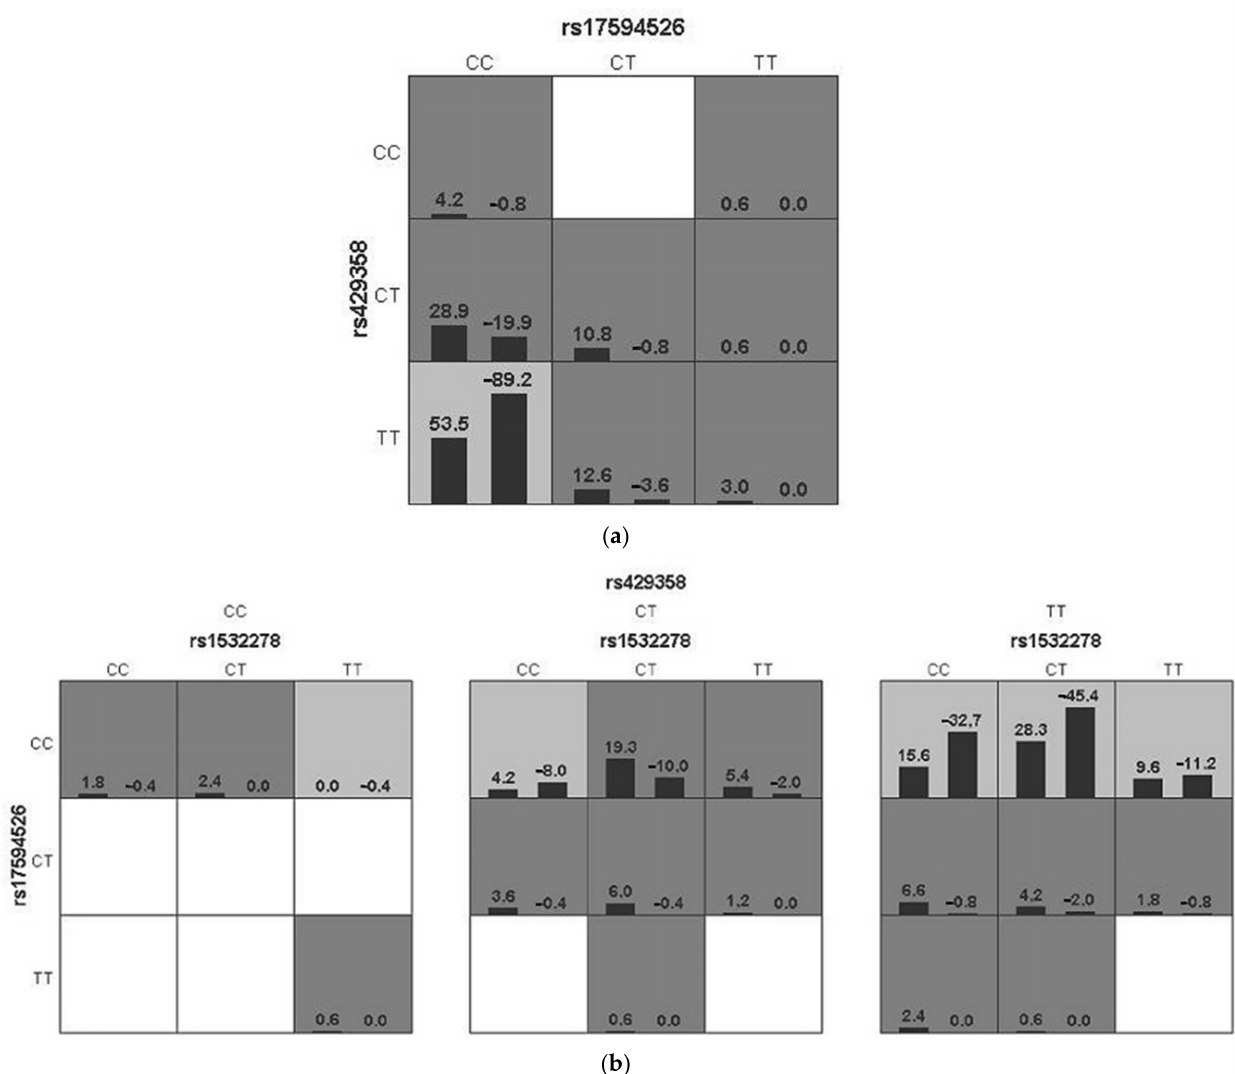
Figure 3. Gene–gene interactions among TCF4 (rs17594526), APOE (rs429358) and CLU (rs1532278) loci in AD and healthy subjects: ( a ) two-factor model; ( b ) three-factor model. The score distribution of AD subjects (left black bar in boxes) and control subjects (right black bar in boxes) is shown for each genotype combination. High-risk genotype combinations are represented by dark gray shade cells, while light gray shade cells represent low-risk genotype combinations. Cells with no shading or white cells represent genotype combination for which no data is